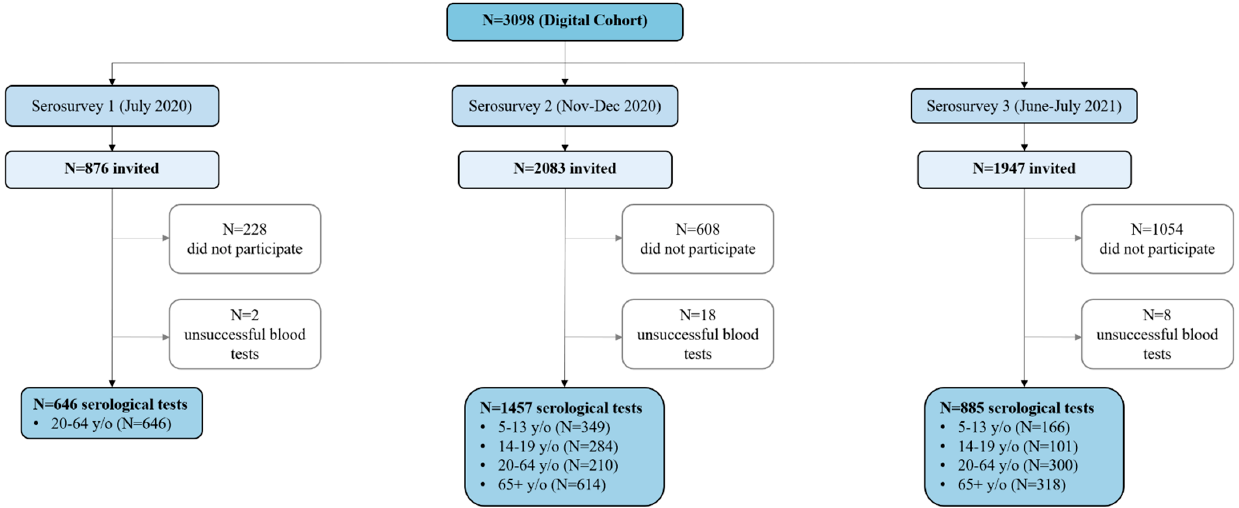
Figure 1. Flow diagram of participants at each serosurvey of the “Corona Immunitas Ticino” study. Descriptive